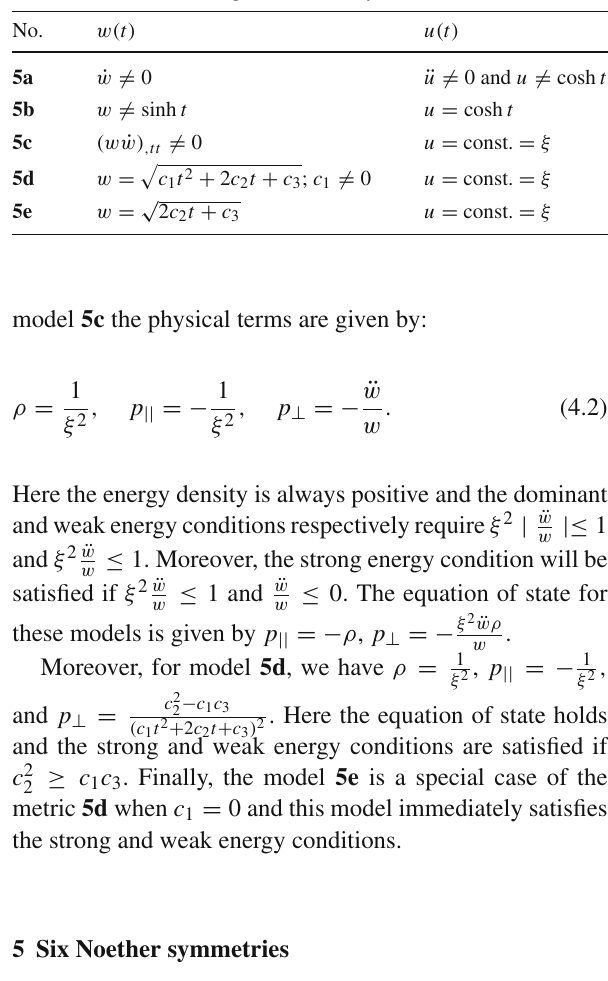
Table 2 Metrics admitting five Noether